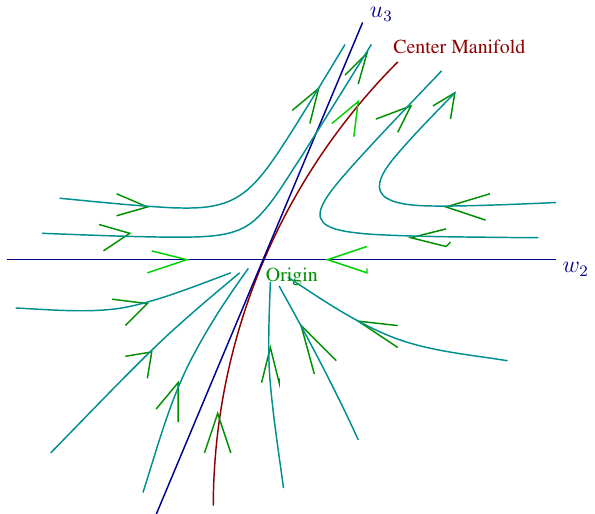
Fig. 3 For H c < 0 and m